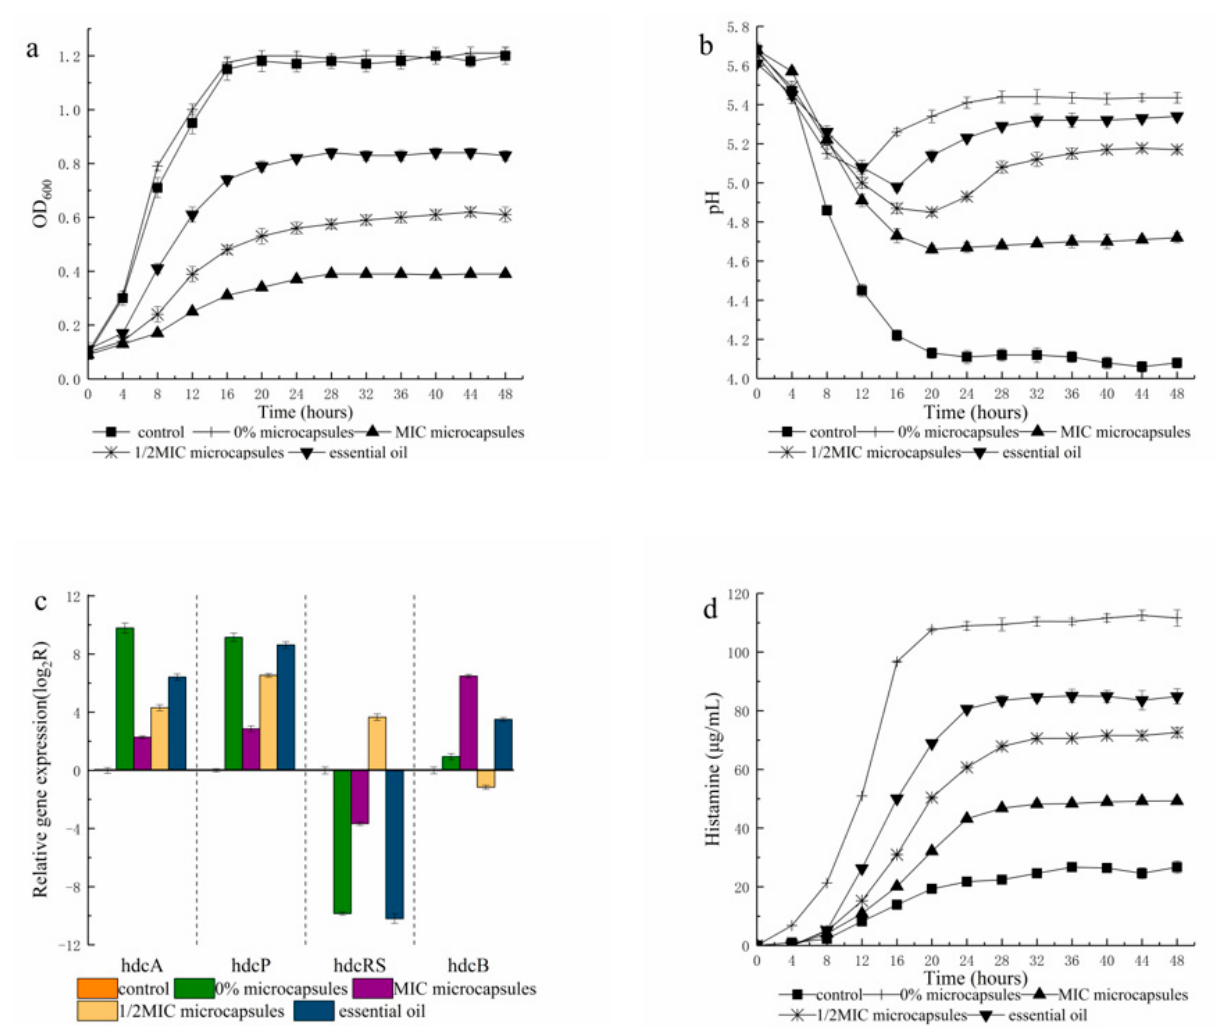
Figure 1. Effect of thyme microcapsules on P. bacillus growth ( a ), pH ( b ), gene expression of HDC cluster ( c ) and histamine accumulation ( d ) during 48 h. Batch Control: without histidine (control); 0% microcapsules: histidine + 0% microcapsules; MIC microcapsules: histidine + MIC microcapsules; 1/2MIC microcapsules: histidine +1/2MIC microcapsules; essential oil: histidine + essential